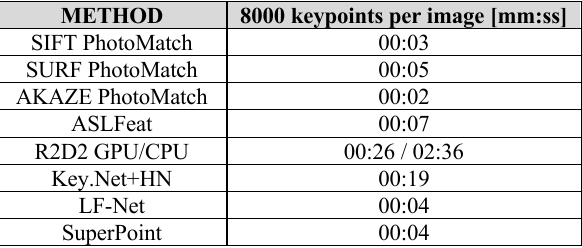
Table 2: Average time required to extract 8000 keypoints per image (1500x1000 px) with the available implementations. For learning-based methods, a variable extraction time of 3-7 minutes must be added for loading the pre-trained model, regardless of the number of keypoints